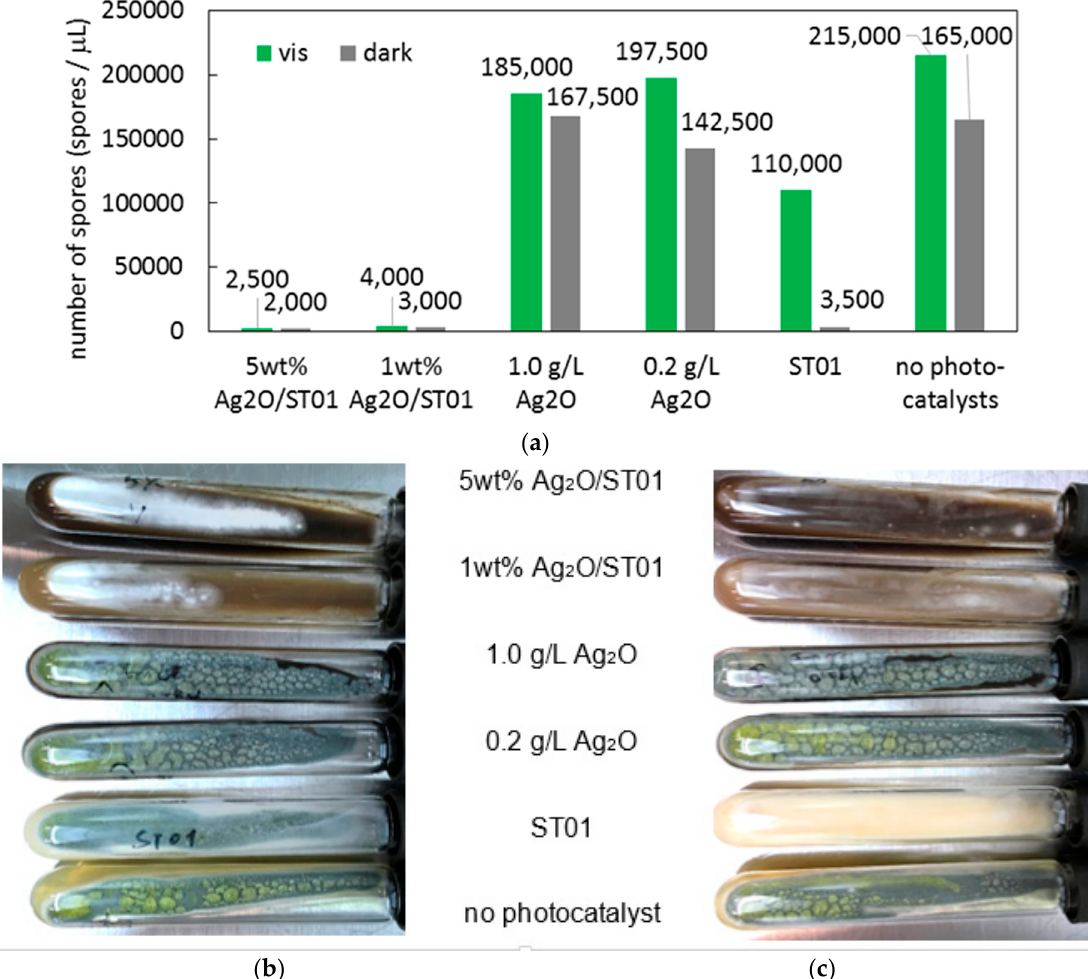
Figure 14. Sporulation after five days growth of P. chrysogenum under florescence light and in the dark ( a ) and representative photographs of slants under florescence light ( b ) and in the dark ( c ).